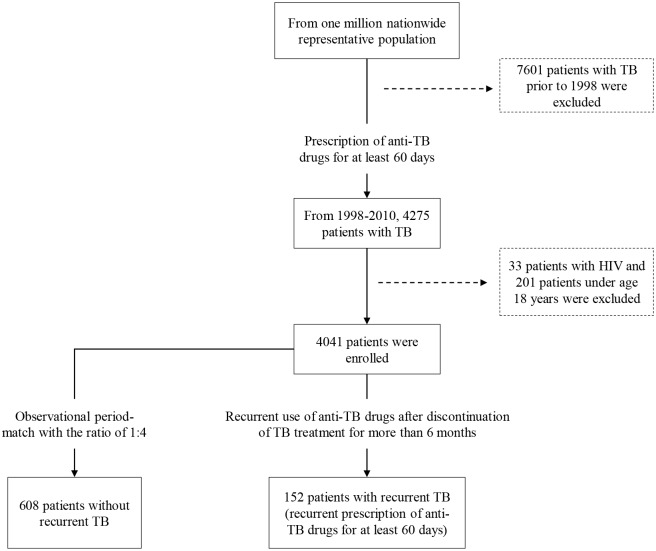
Flow diagram for the enrollment of study participants in the nested case-control study.After excluding patients with antecedent TB prior to 1998, HIV infection and those less than 18 years of age, the numbers of nested cohort, case and control were 4041, 152 and 608, respectively.